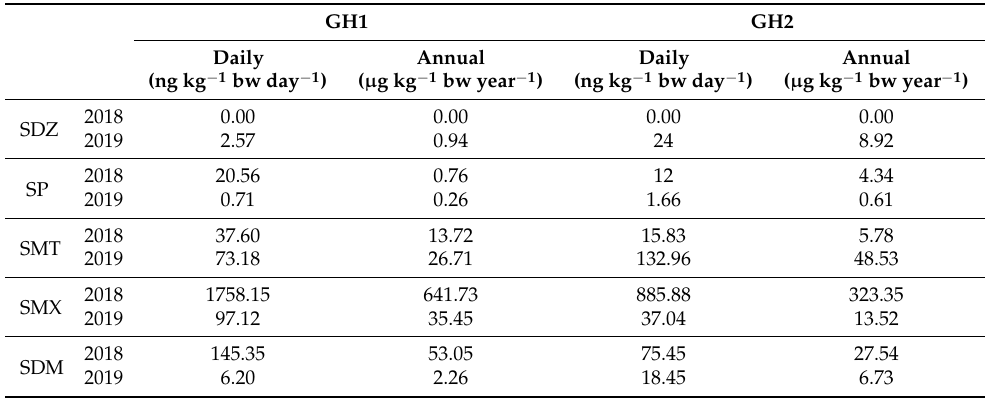
Table 8. Human exposure to sulfonamides (sulfadiazine (SDZ), sulfapyridine (SP), sulfamethizole (SMT), sulfamethoxazole (SMX) and sulfadimethoxine (SDM)) in in edible parts of tomato (fruit). The results are expressed in ng kg − 1 body weight day − 1 for the daily exposure and µ g kg − 1 body weight year − 1 for annual